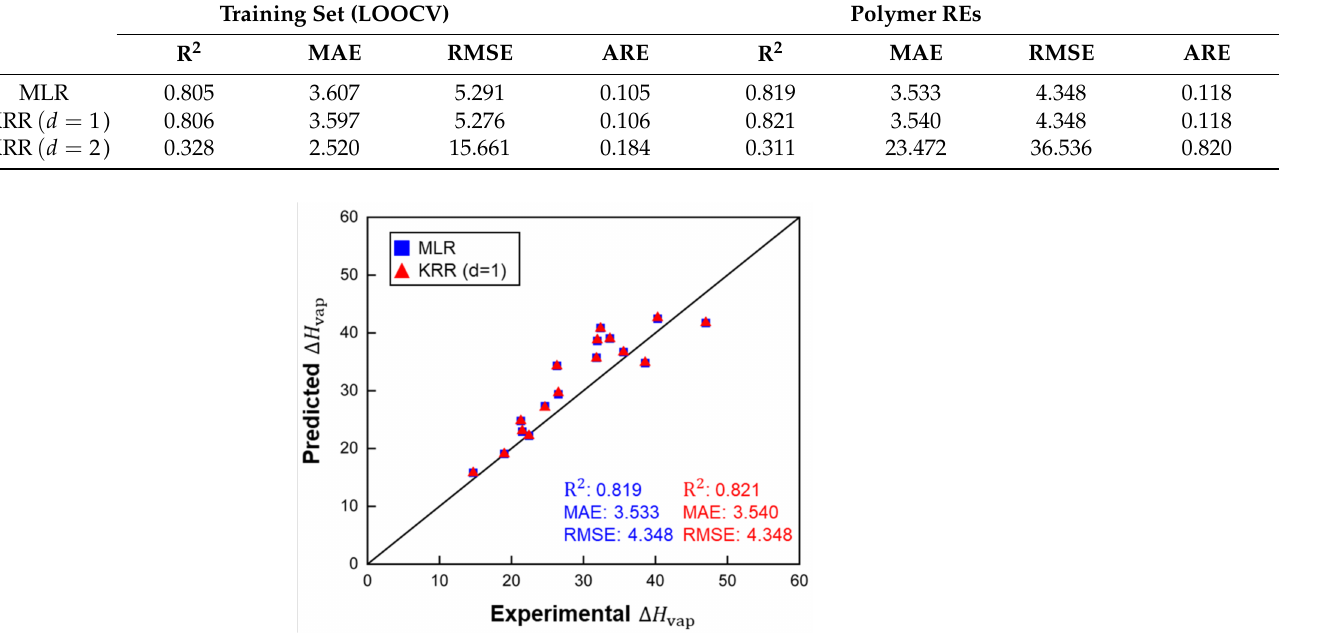
Figure 6. ∆ H vap predictions of polymer RE by MLR and KRR ( d = 1), ARE for MLR: 0.118 and for KRR ( d = 1): 0.118. ∆ H vap , MAE and RMSE in kJ/mol.